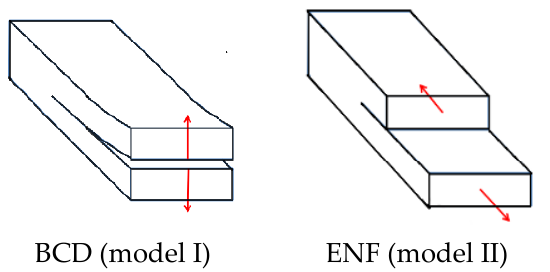
Figure 3. Example diagram of pure model I and pure model II delamination failure of composite materials.